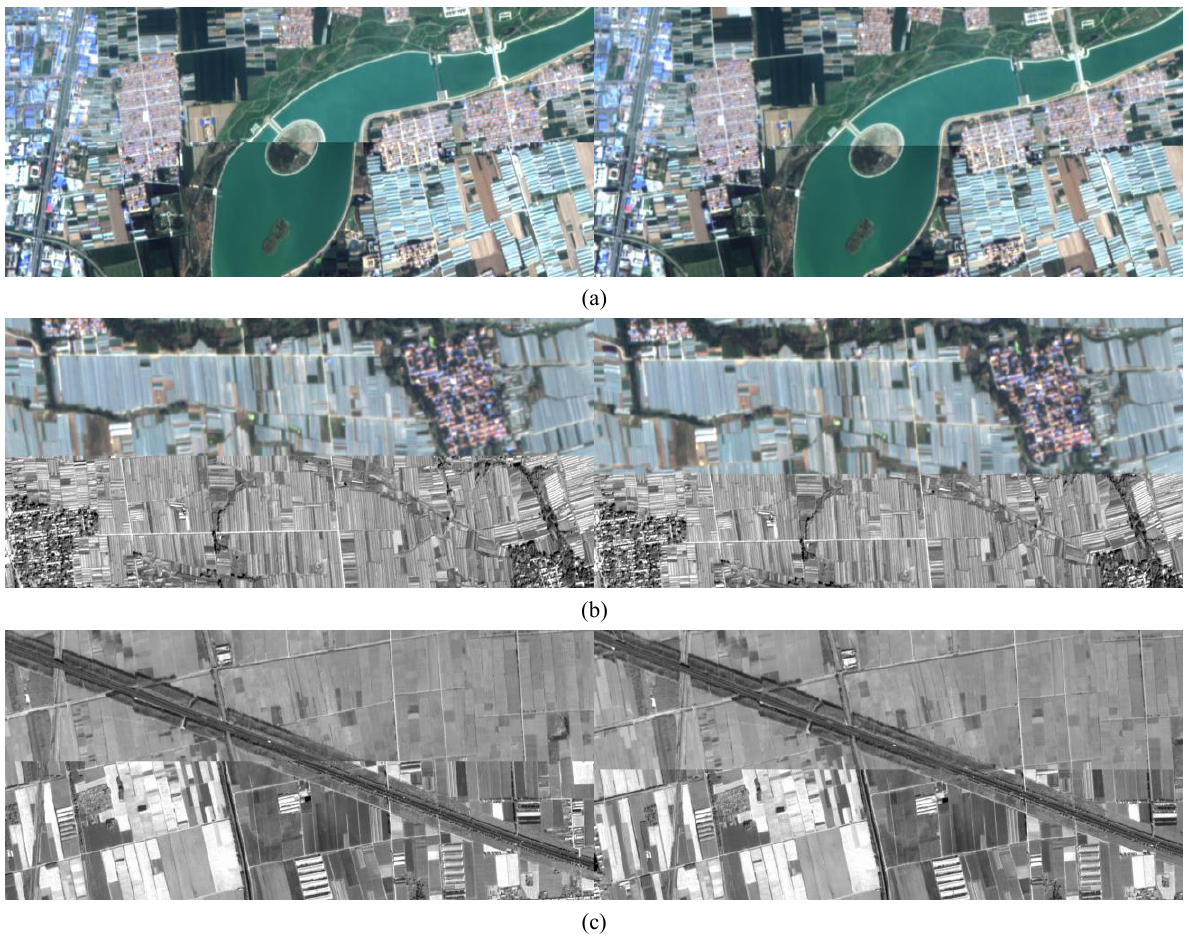
Figure 4. Example of splicing shown in vision before and after